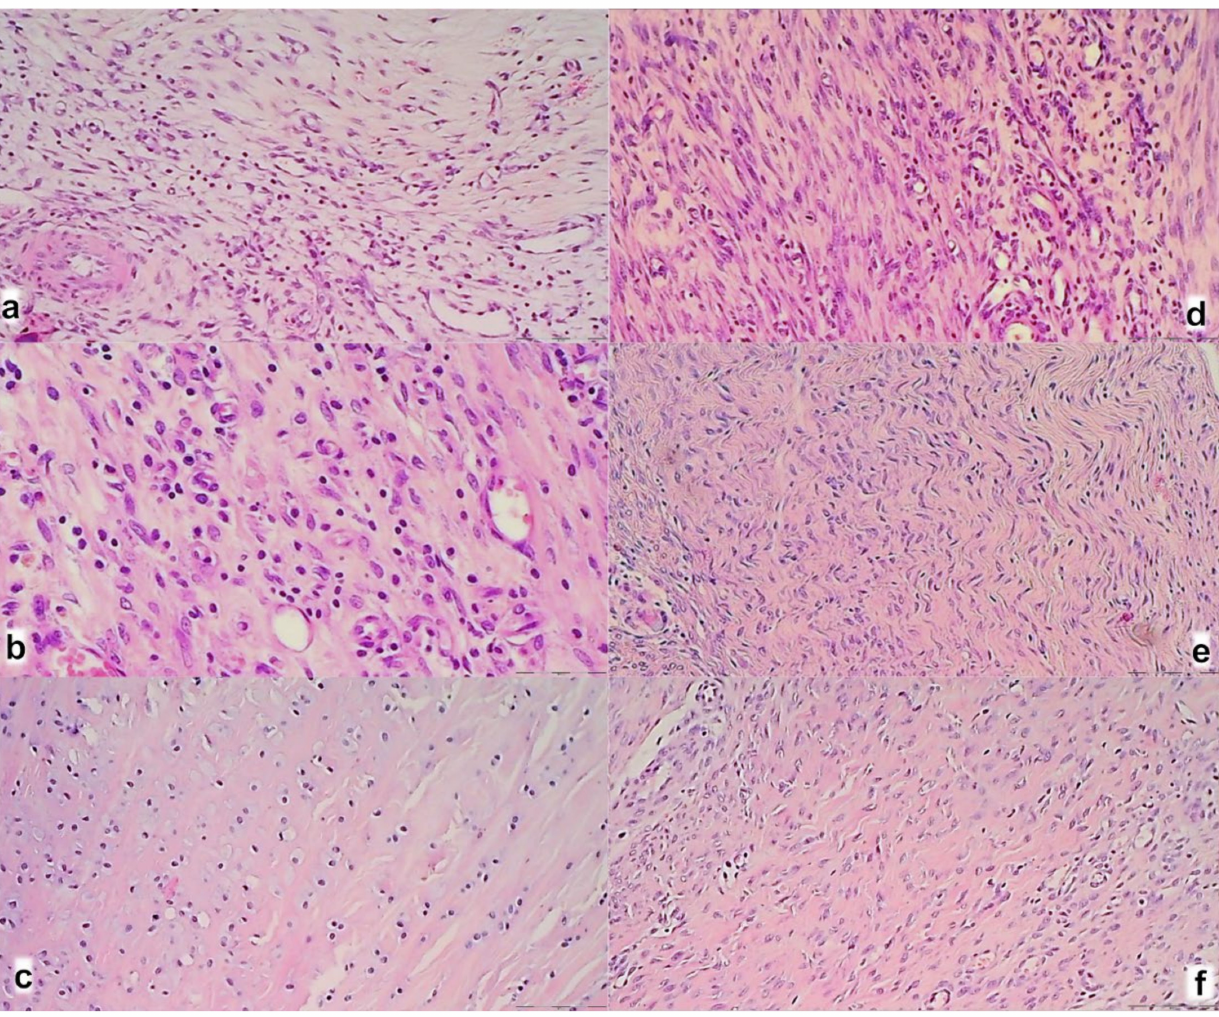
Figure 9. A myotendinous junction area in control ( a – c ) and BPC 157 treated rats ( d – f ); at day 7 ( a , b ), day 14 ( b , e ), and day 28 ( c , f ) after myotendinous injury. (HE; magnification ×